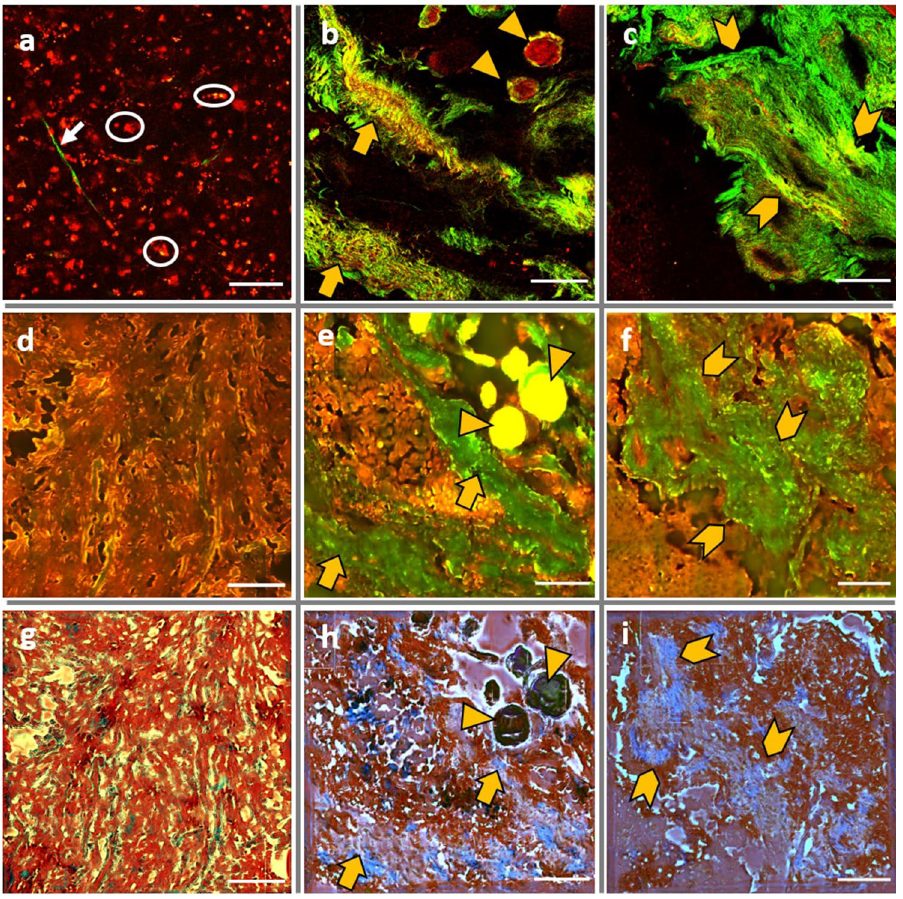
Figure 3. Image comparison through the NIR and DUV imaging set-up presenting a comparison between control ( a , d , g ), Grade I meningioma ( b , e , h ) and Grade II meningioma ( c , f , i ) through NIR confocal TPF + SHG images ( a – c ) 890 nm as excitation wavelength, and through DUV Tryptophan + Collagen full field images ( d – f ) using 275 nm as excitation wavelength. MT3 virtual staining Images ( g – i ); scale bar: 100